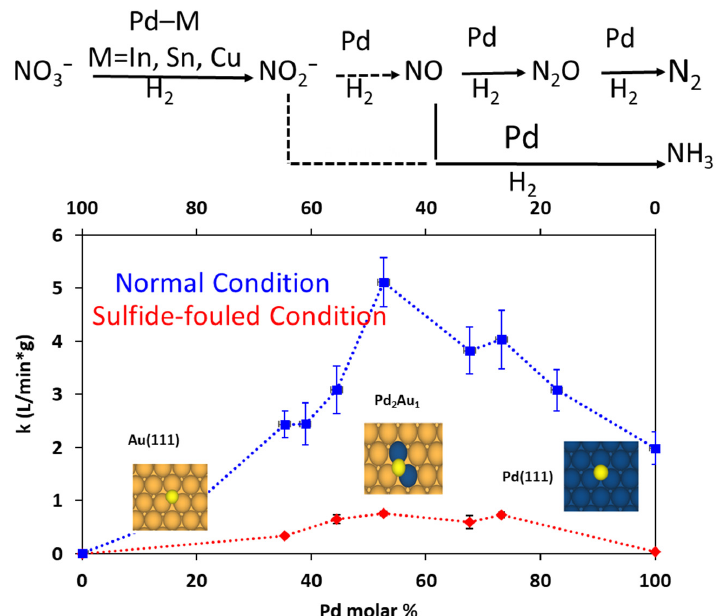
Figure 21. Overall reaction scheme is shown on top; total mass (metal) normalized first-order rate constants of SiO 2 -supported NP catalysts for different Pd x Au 100- x compositions, original activity is shown in blue whereas sulfide fouled activity is shown in red, the three images show top views of absorbed sulfur atom upon Au-rich, Pd x Au 100- x alloyed, and Pd surfaces (left-to-right). Adapted with permission from the American Chemical Society. Copyright 2017 American Chemical Society.